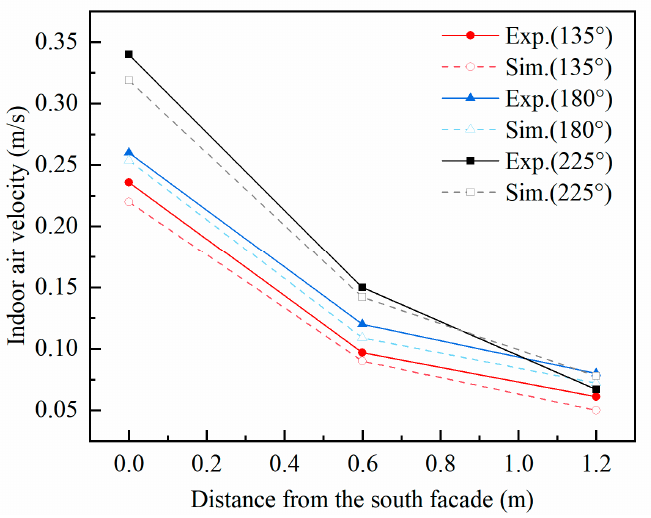
Figure 16. Validation of simulated and experimental indoor air velocity distribution for different wind directions.